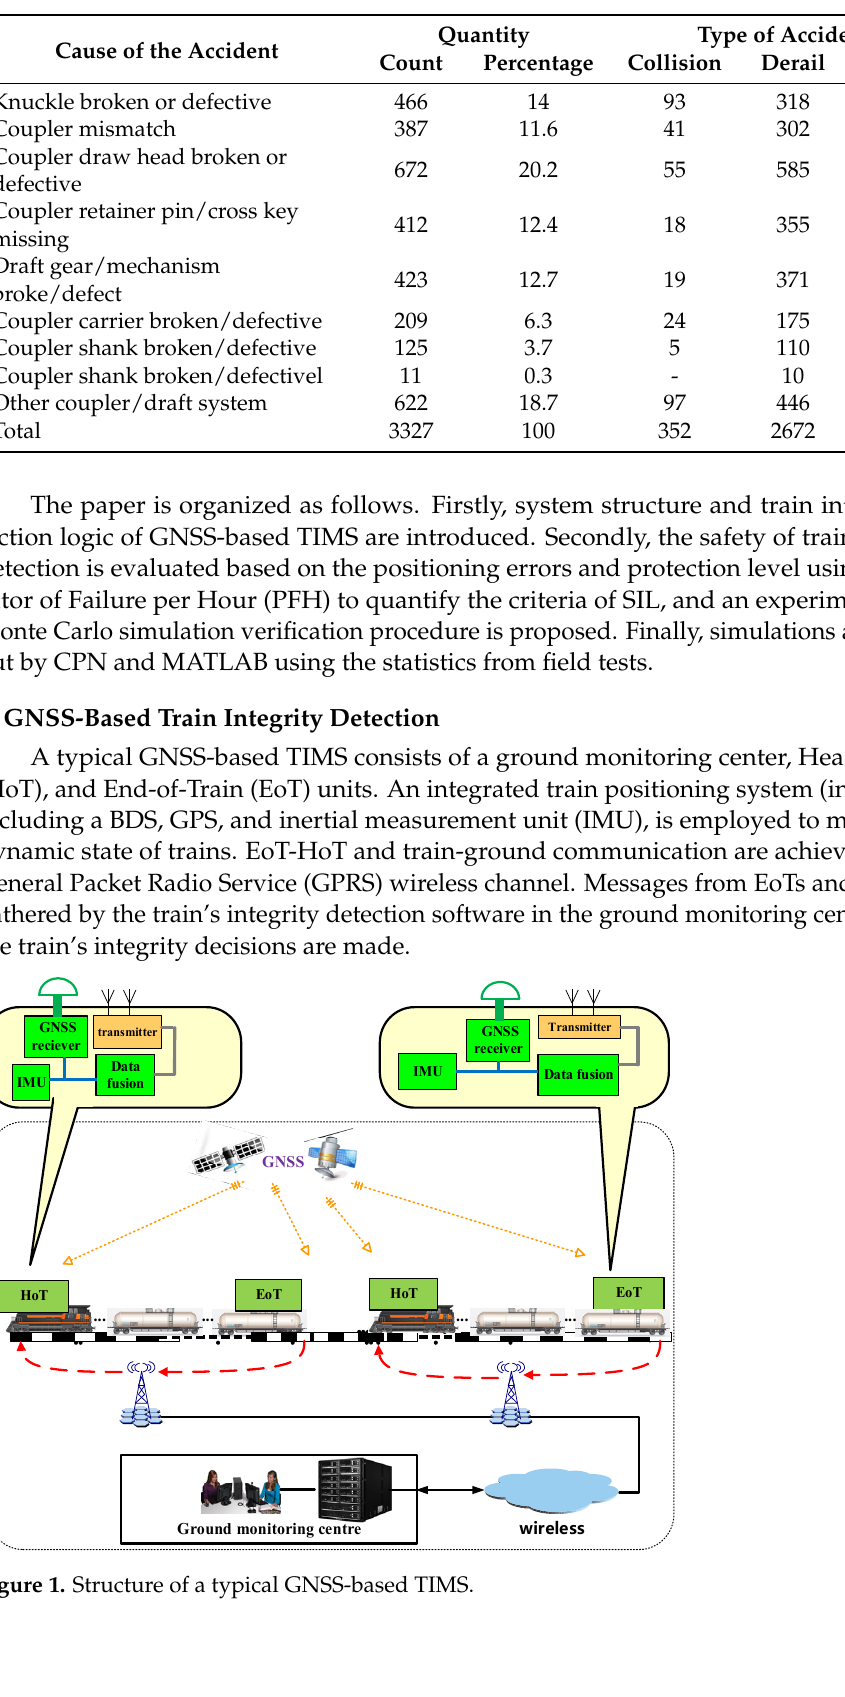
Figure 2. Timeline diagram of a train integrity detection under potential collision risk. TIMS is based on GPS/BDS and integrated with an IMU sensor to realize train local- ization. The GNSS-based train position error is the absolute difference between the esti- mated position and the actual position in two dimensional space [1,2], while the protection level (PL) is the uncertainty of location estimation, extending in a bounded domain under a certain confidence probability [13,14], bound to the horizontal PL with a probability de- rived from the integrity requirement (see Figure 3). Then we can form a safe train position description.